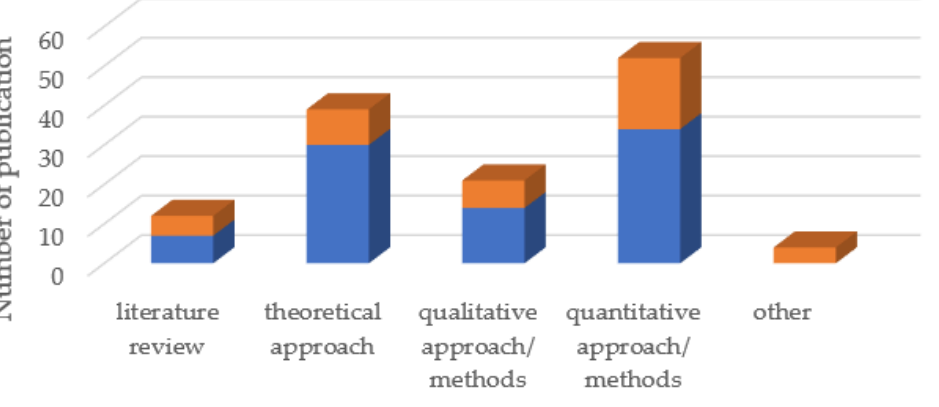
Figure 5. Relation of the total number of filtered publications and applied methods in the period 2012 – 2022.